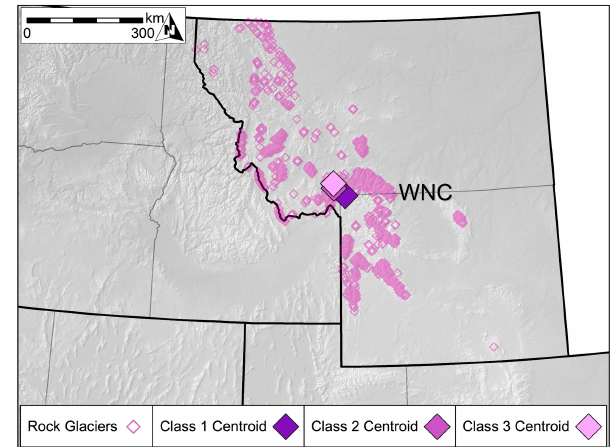
Figure 7. Locations of SW Region rock glacier inventory features ( n = 4870), as well as centroids for Class 1 ( n = 3291), Class 2 ( n = 1133), and Class 3 ( n = 446) features. Rock glaciers of the SW Region are largest and most densely concentrated in the Front Range and San Juan Mountains of Colorado and the Uinta Moun- tains of Utah.